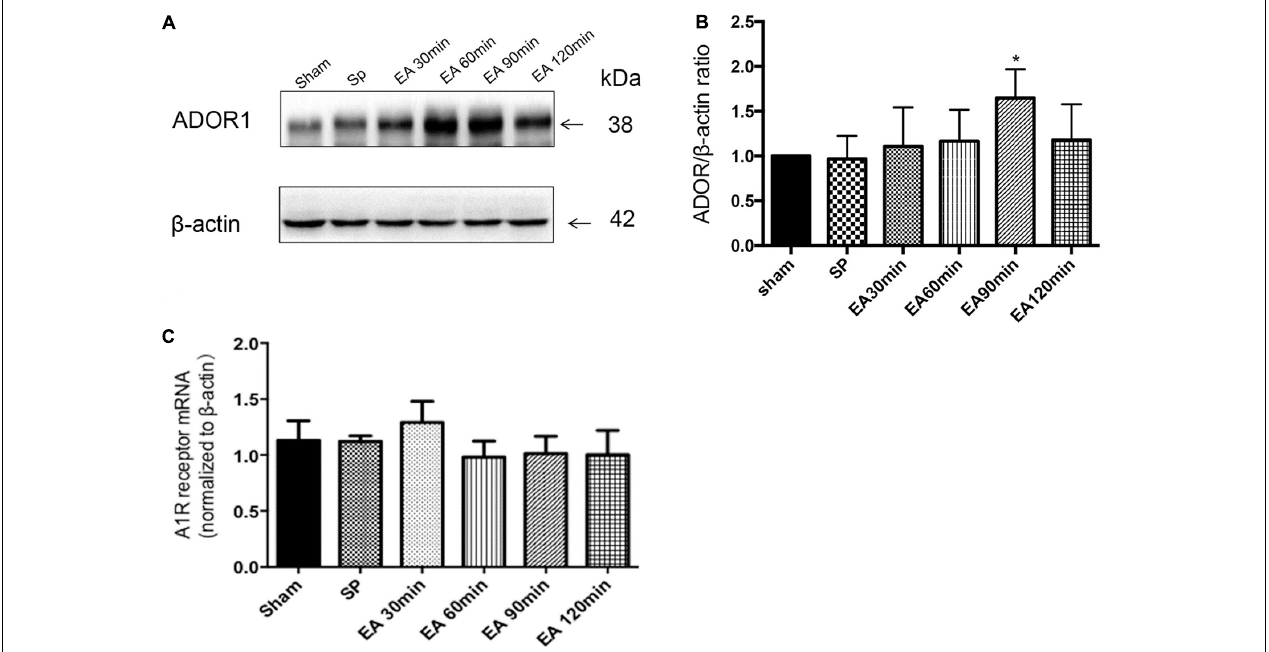
FIGURE 1 | Effects of electroacupuncture (EA) on A1R expression ( n = 4), as assessed using Western blot and RT-PCR. (A,B) Pretreatment with EA significantly increases the expression of A1R protein at 90 min after the completion of EA; (C) there is no significant on the expression of A1R mRNA at the times after the completion of EA. * P < 0.01 vs. the sham